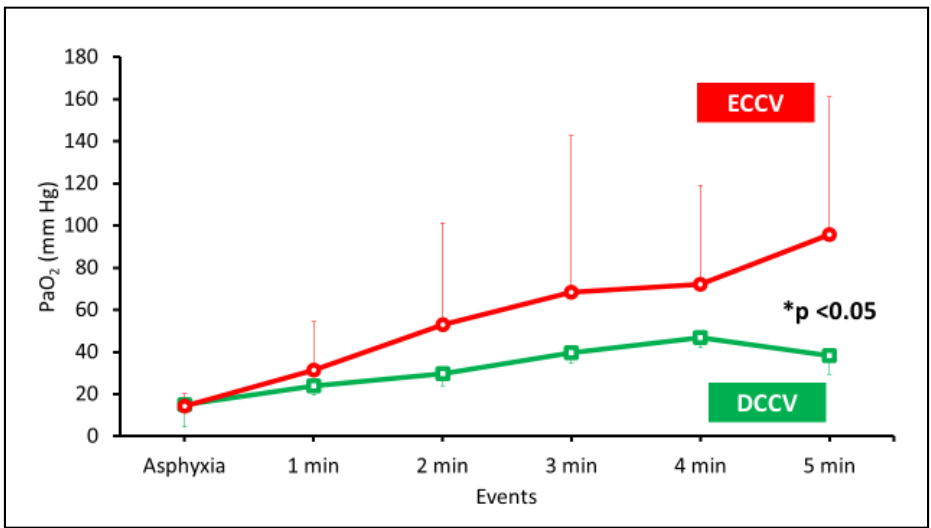
Figure 4. The PaO 2 in mm Hg is shown on the y-axis and the events or duration of PPV on the x-axis. The PaO 2 was significantly lower in DCCV (* p < 0.05 by ANOVA).